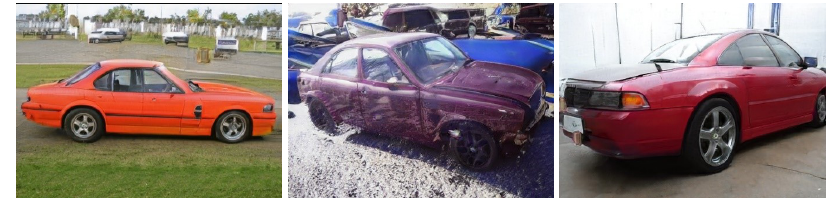
Figure 10. Images of cars generated by the StyleGAN neural network trained on the original LSUN car